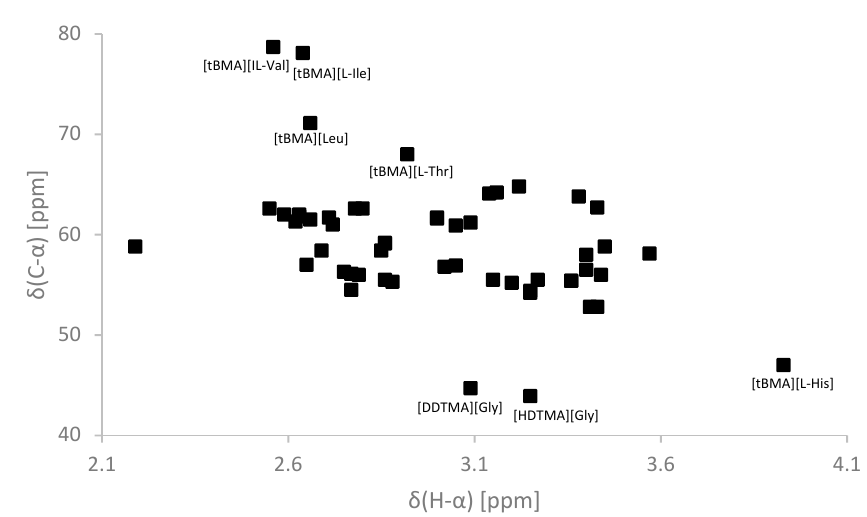
Figure 1. Plot of C- α chemical shifts vs. H- α chemical shifts (ppm).